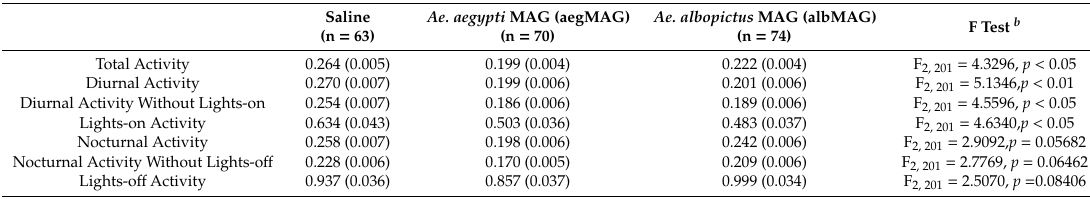
Table 1. Locomotor activity indices (standard error) of Ae. albopictus females injected with saline, MAG of Ae. aegypti and MAG of Ae. albopictus .